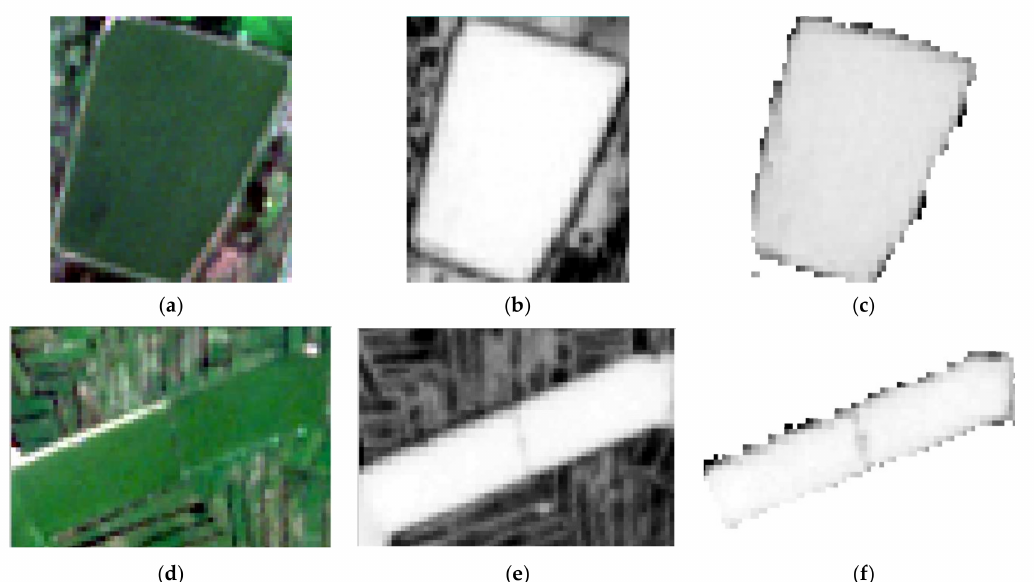
Figure 3. Water extraction results: ( a ) Sentinel-2 RGB image; ( b ) MBWI grey image; ( c ) the water extraction; ( d ) Sentinel-2 RGB image; ( e ) MBWI grey image; and, ( f ) the result of water extraction.